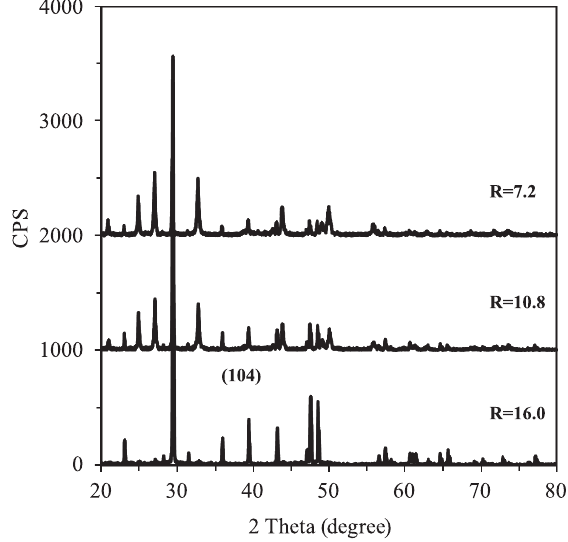
Fig. 3 X-ray diffraction patterns of CaCO 3 particles prepared from octylamine/water bilayer systems. Note the inten- sity decrease from calcite to vaterite. Miller indices from JCPDS ICDD 5-0586 (calcite) and JCPDS ICDD 33-268 (vaterite).